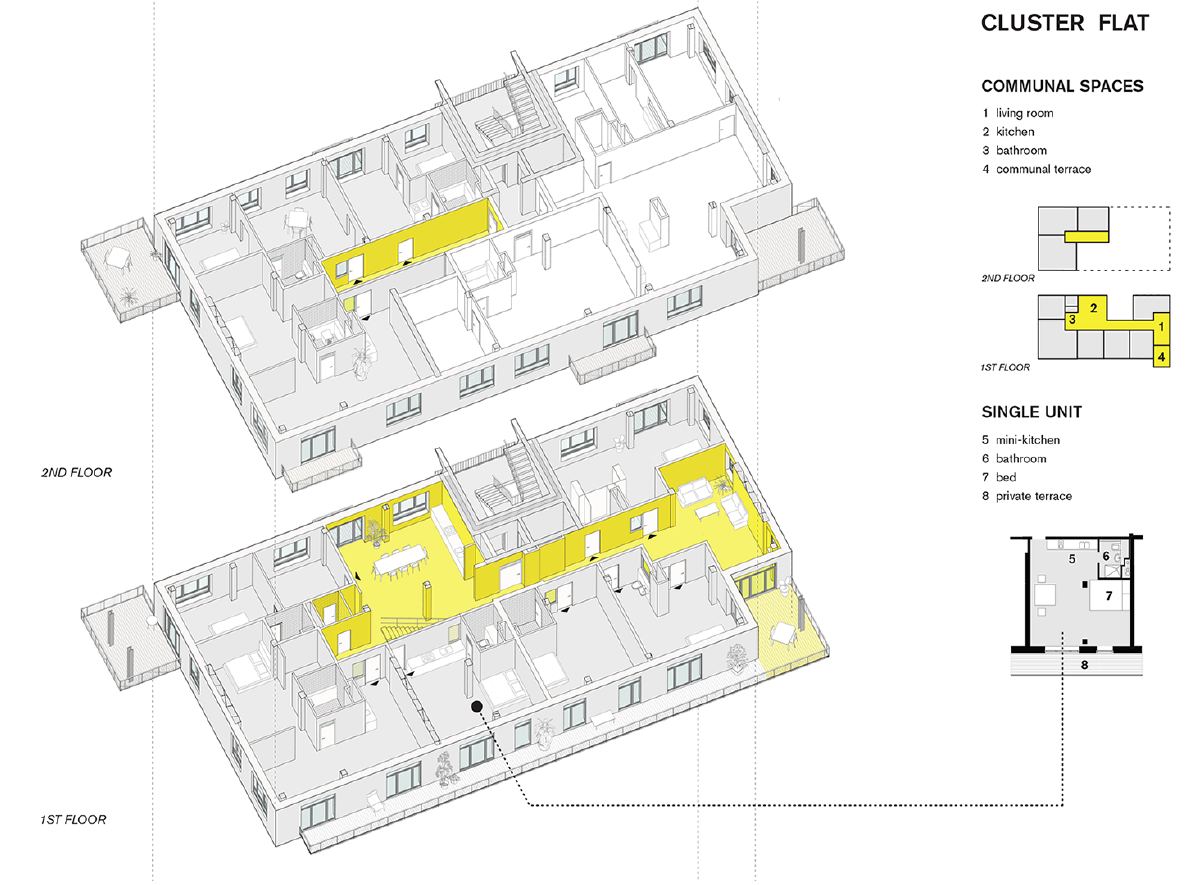
Figure 15. Spreefeld (axonometry of cluster apartment), Berlin, 2014, by Carpaneto Architekten, Fatkoehl Architekten and BARarchitekten. Image courtesy of Fatkoehl Architekten. Note: The highlighted areas correspond to the shared